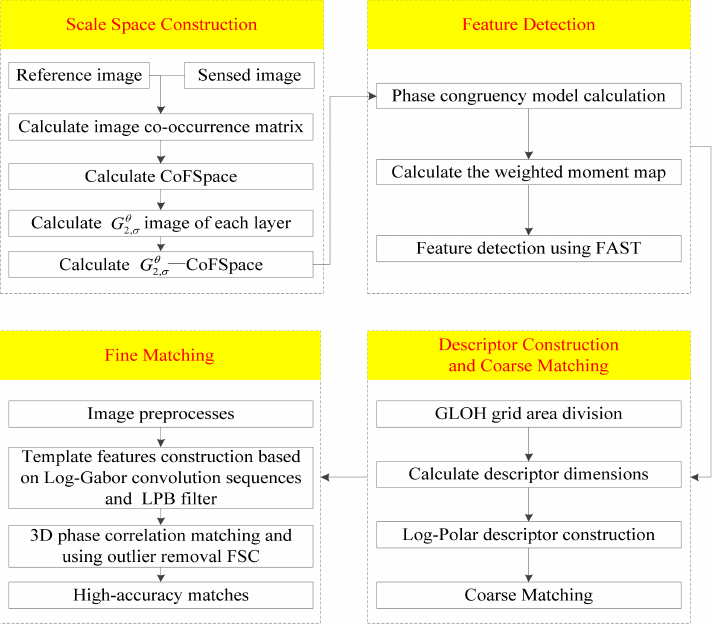
Figure 1. The framework of the matching